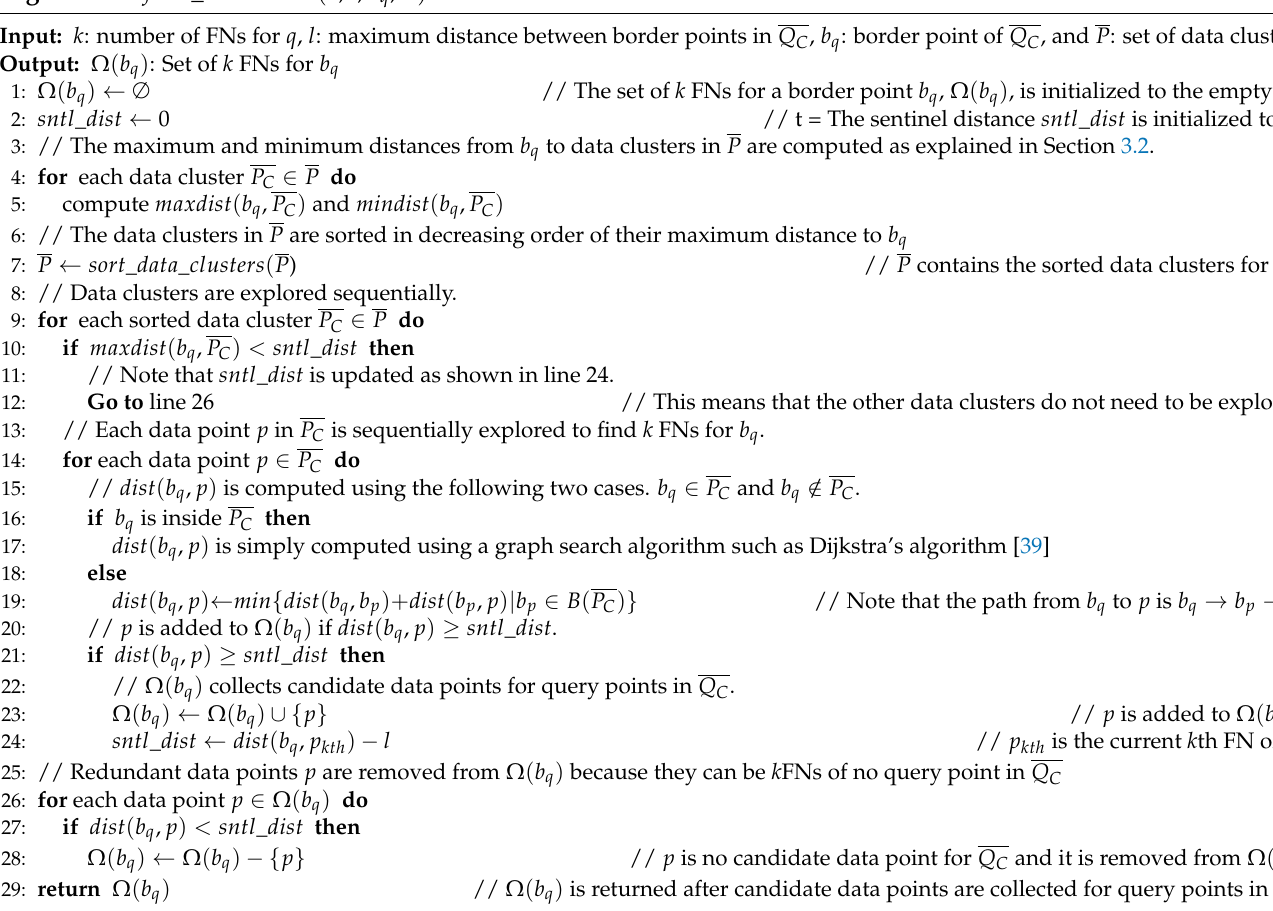
Algorithm 3 f ind _ candidates ( k , l , b q , P )